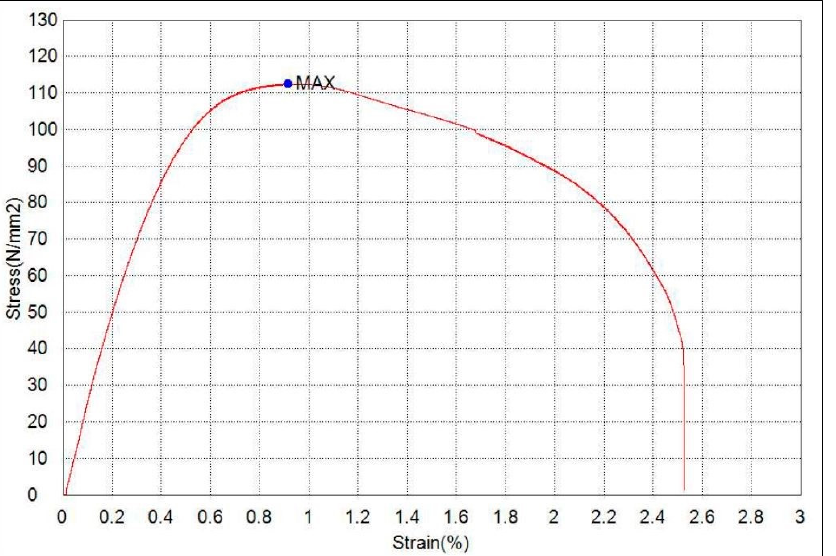
Figure 3. Tensile test results.